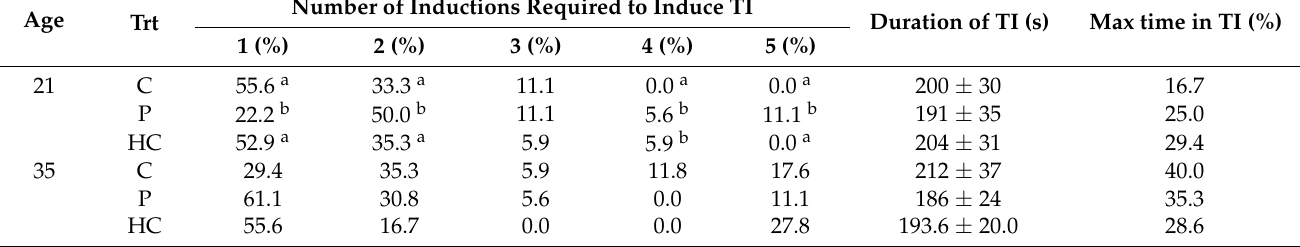
Table 3. Number of inductions required to induce a state of tonic immobility (maximum 5), duration of tonic immobility (TI) and the proportion of chickens that stayed in TI for the maximum time permitted (10 min) for chickens that were raised under standard conditions (C); with additional physical items (P); or with additional human contact (HC). Differing superscript within a column indicates treatment differences at p < 0.05.